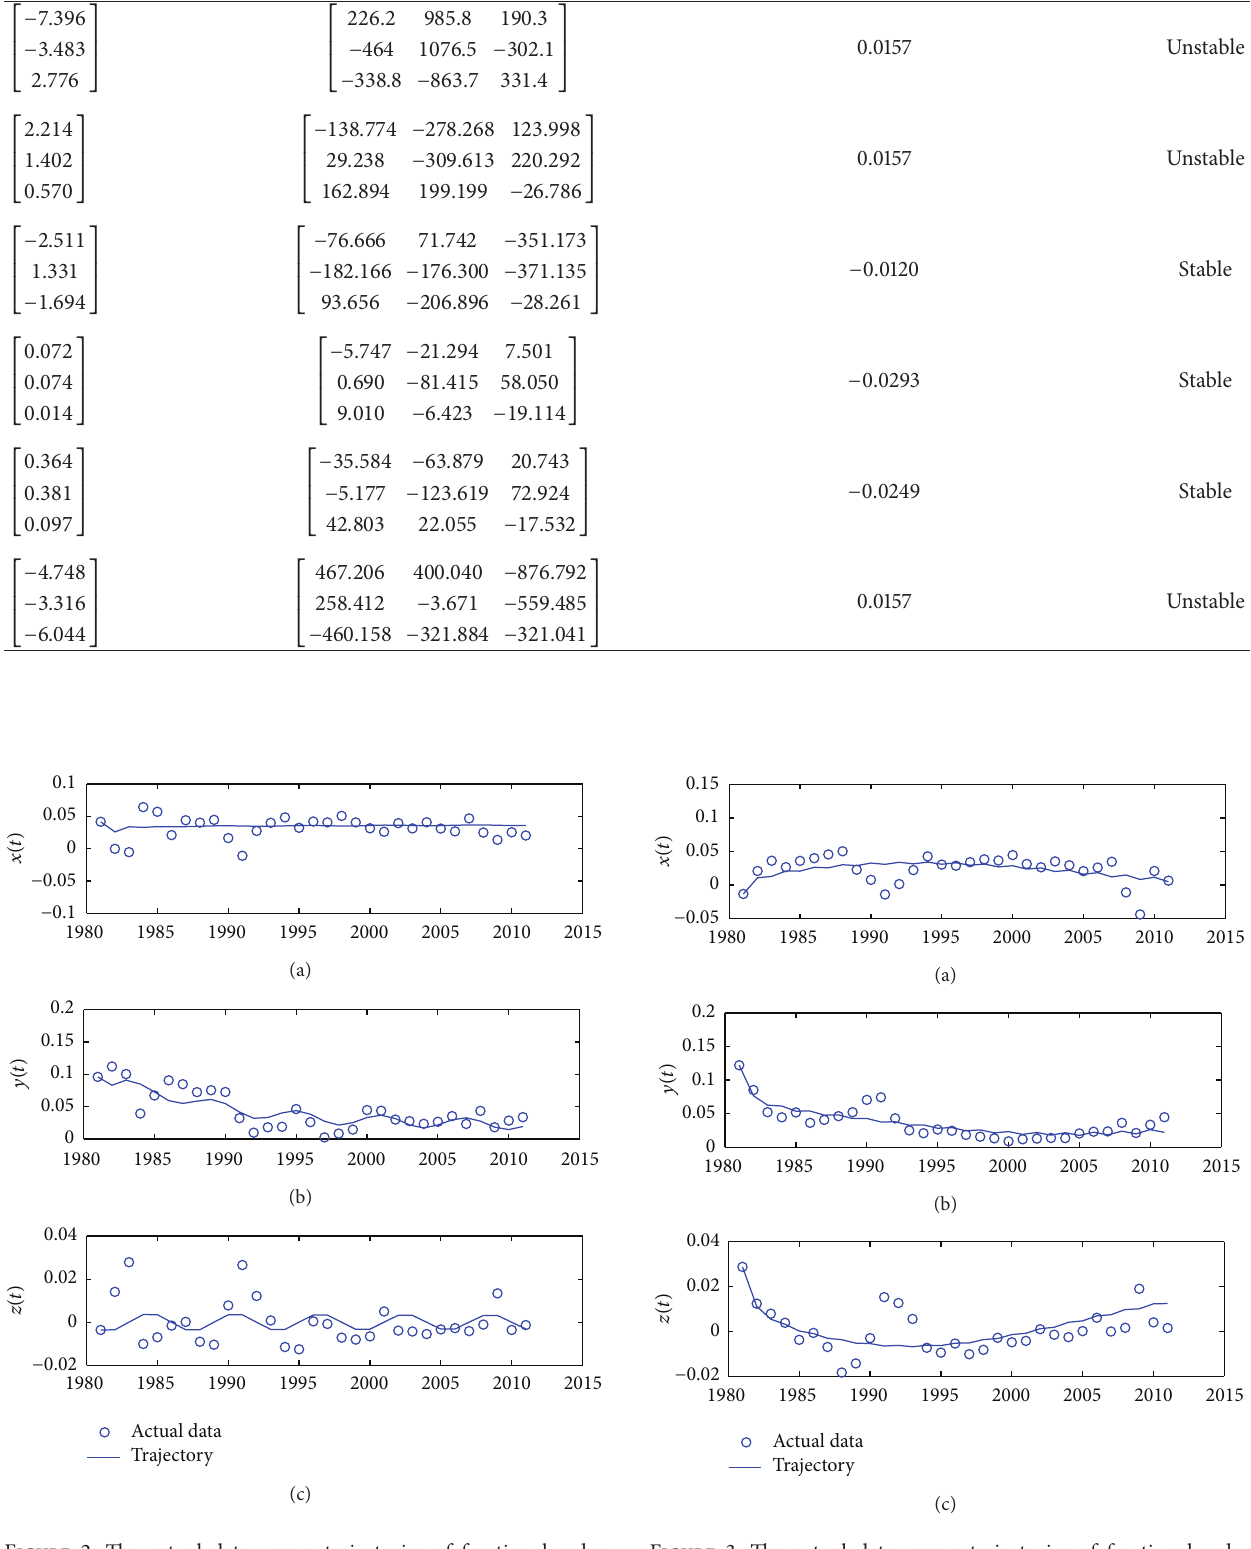
Figure 3: The actual data versus trajectories of fractional-order system in each dimension about